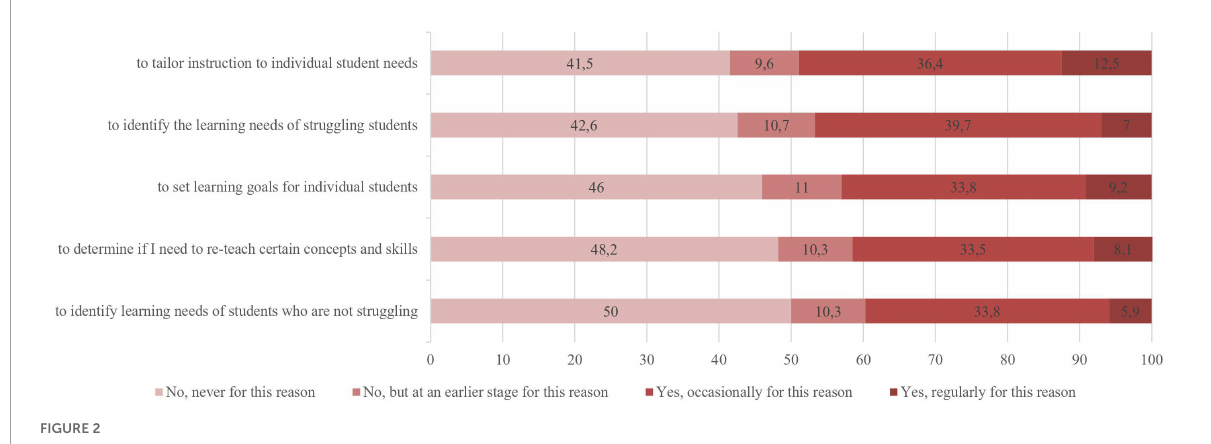
FIGURE2 Previous and current usage of learning data from digital learning platforms